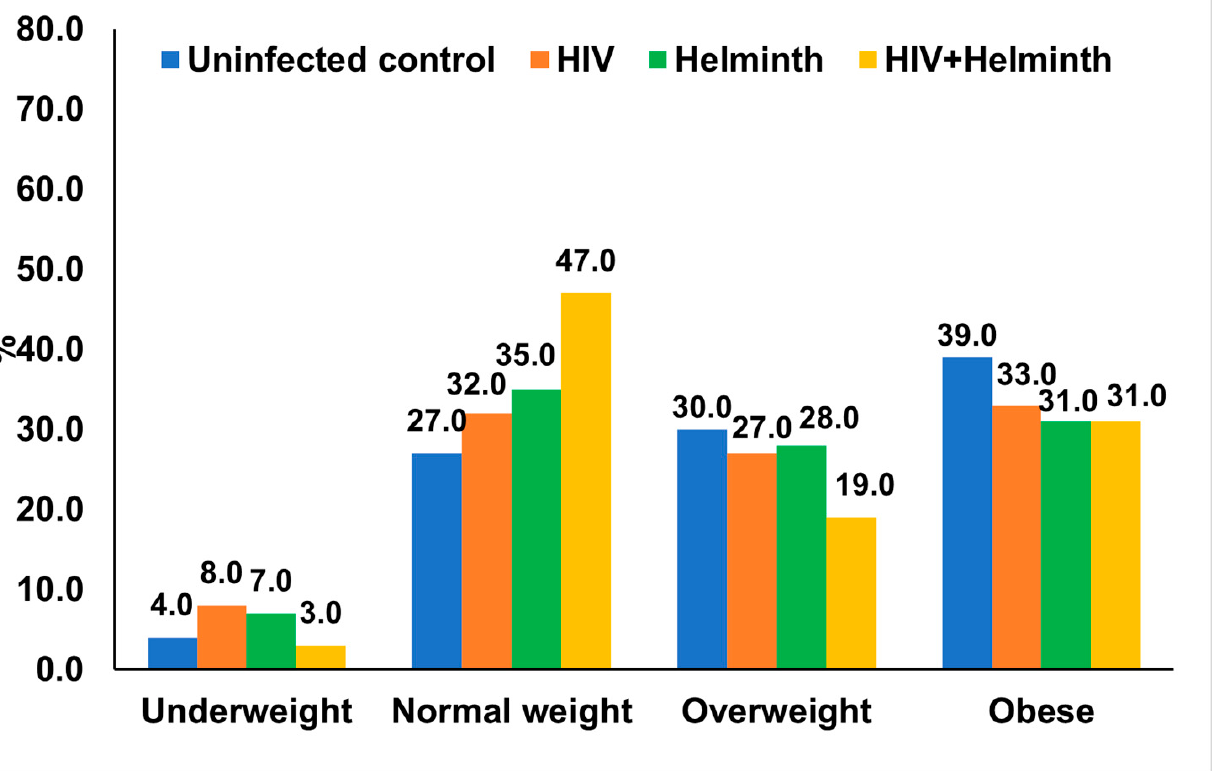
Figure 3. Body mass index distribution in the study population stratified based on infection status.